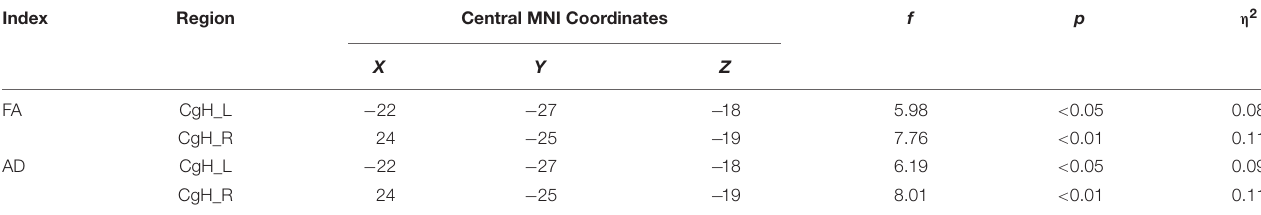
TABLE 3 | Significant diffusion tensor imaging (DTI) index differences between MPD group and control group (MPD group < control group). Index Region Central MNI Coordinates f p